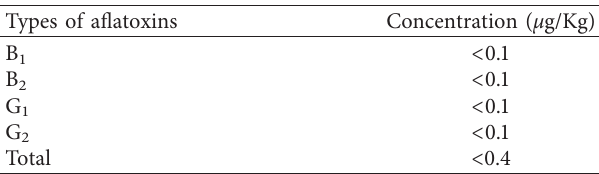
Table 3: Aflatoxin concentration of the crude enzyme extract from A. oryzae